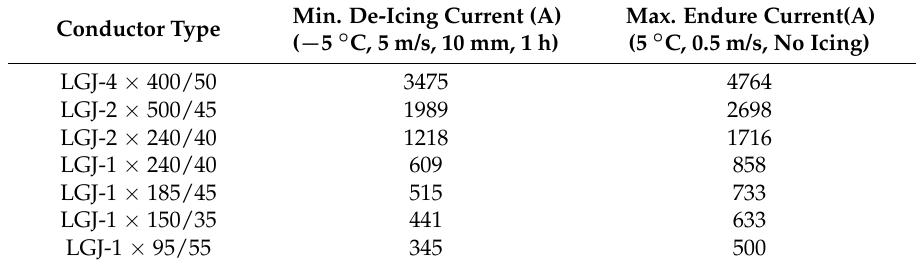
Table A1. The minimum de-icing current and maximum endure current for typical power lines [5].